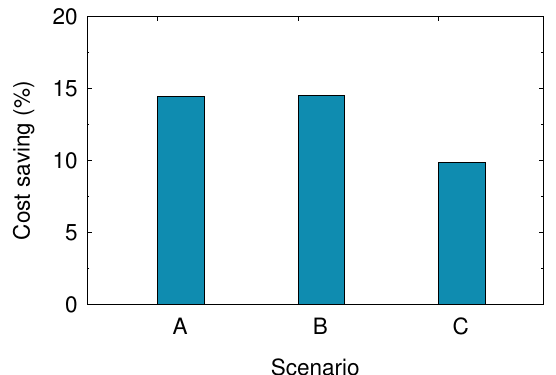
Figure 12. Cost-saving achieved by installing the same total PV panel capacity (80 kWh) according to different configuration scenarios: ( A ) 20 kWp per DC in four DCs; ( B ) 40 kWp per DC in two DCs; ( C ) 80 kWp in a single